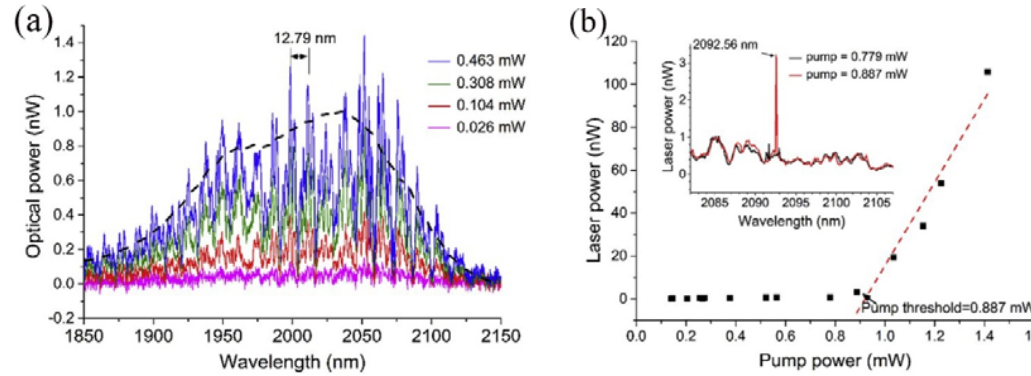
Figure 13. ( a ) Spectrum of WGMs in the tellurite glass microsphere; ( b ) relationship between the output laser power and pump power; inset: spectral output when the pump is below (blue line) and above threshold (red line). Reprinted/Adapted with permission from [81].